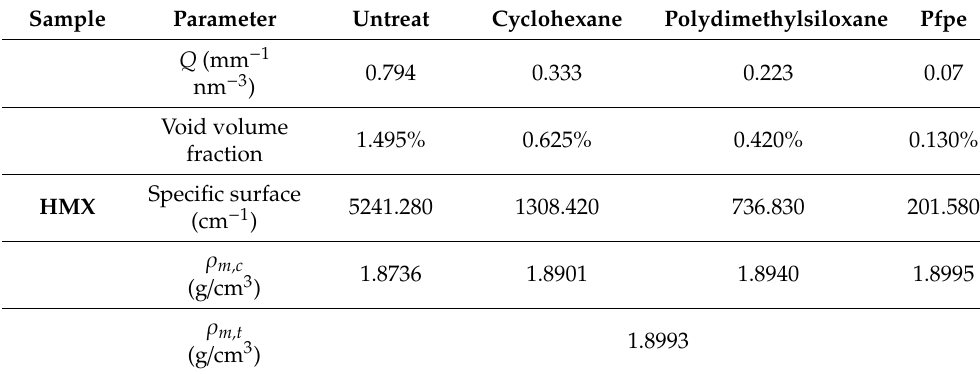
Table 1. Calculation results of parameters of 1,3,5,7-tetranitro-1,3,5,7-tetrazacyclooctane (HMX) crystal under di ff erent